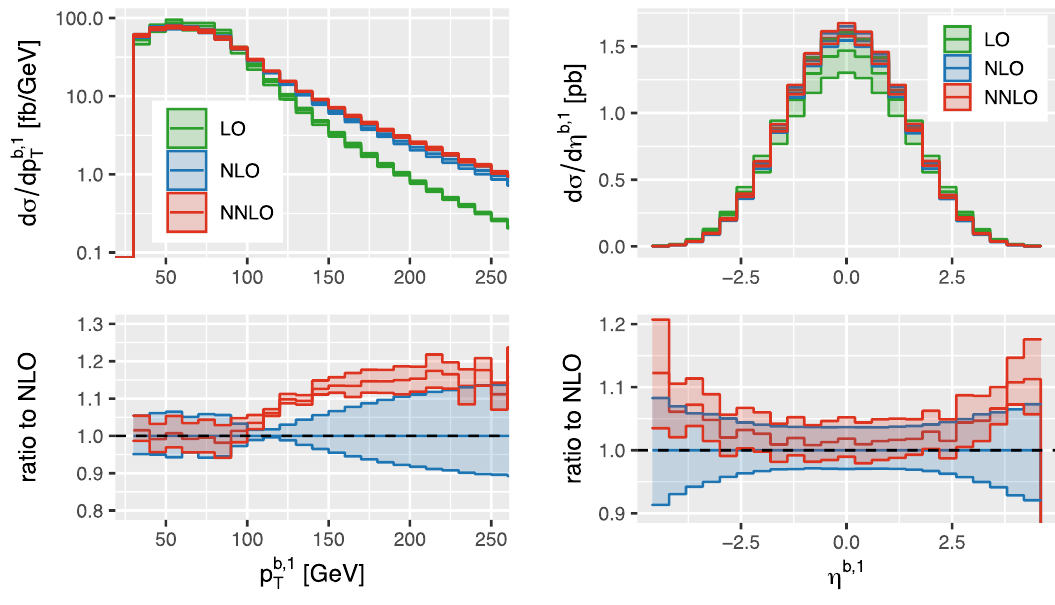
Figure 13 . p T -leading b -tagged jet transverse momentum distribution (left) and pseudorapidity distribution